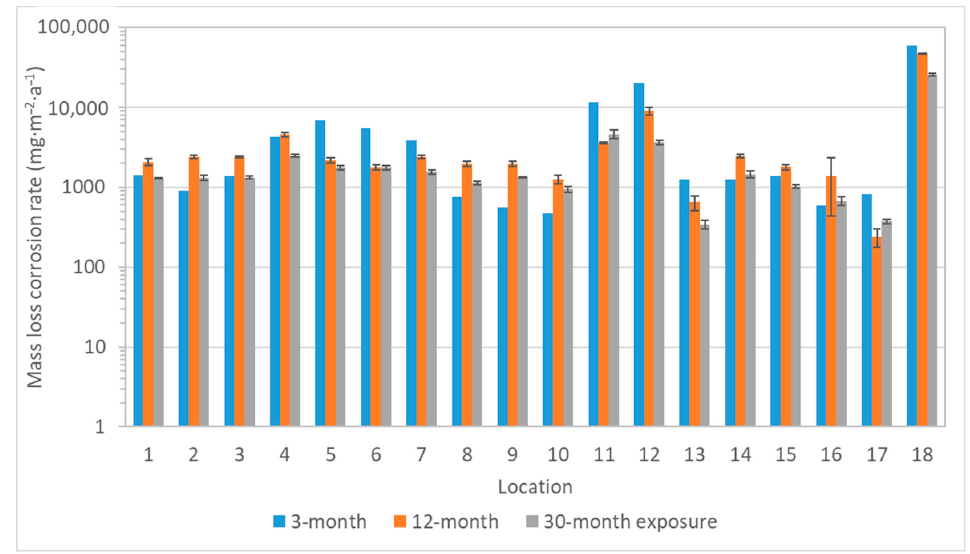
Figure 14. Corrosion rate calculated from mass loss of lead coupons (logarithmic y-axis scale, error bars for 3-month exposure are missing due to the small number of exposed samples).